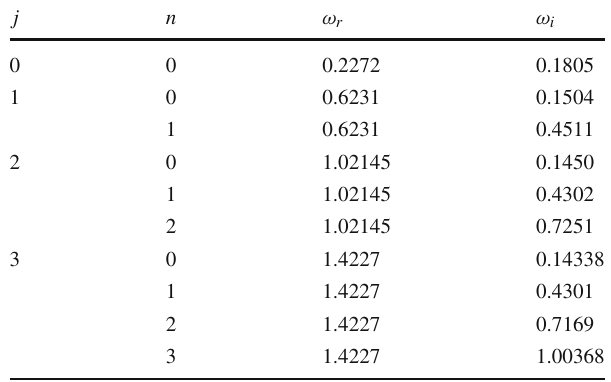
Table 3 The values of the quasinormal frequencies in the (large) non- Schwarzschild geometry for the values of parameters r + = 2 . 0 , M =